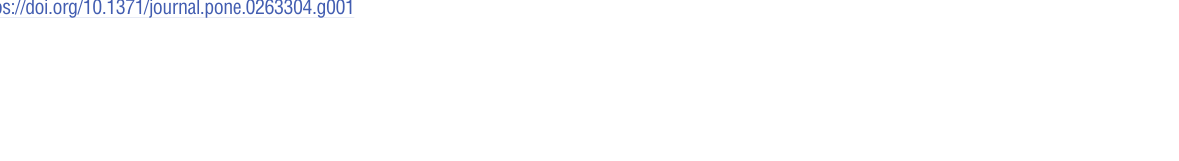
PLOS ONE | https://doi.org/10.1371/journal.pone.0263304 January 28, 2022 5 /